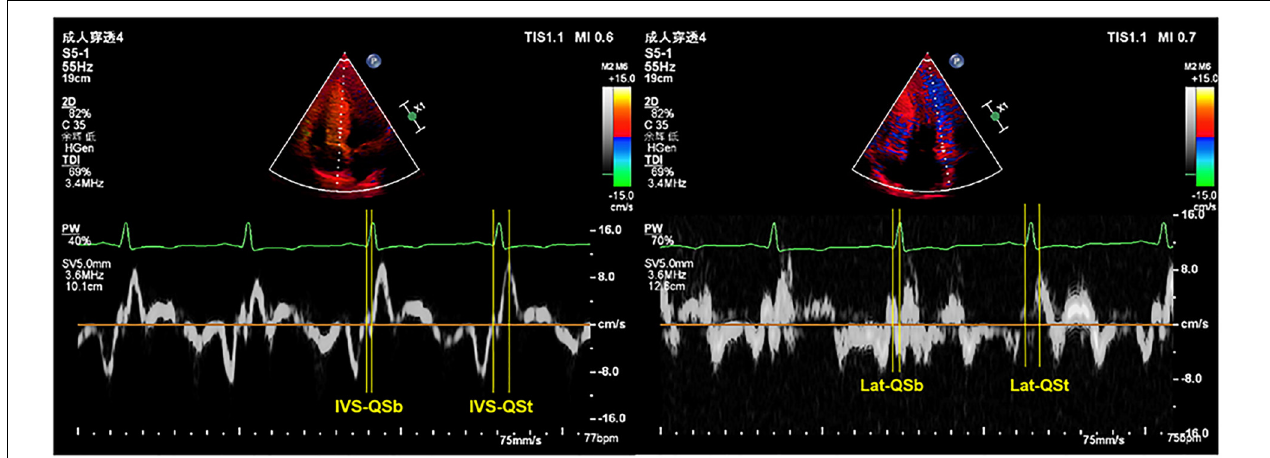
FIGURE 1 | Representative images of TDI combined with ECG to measure the electromechanical coupling time. TDI, tissue Doppler imaging; ECG, electrocardiography; IVS, interventricular septum; Lat, lateral wall; QSb, from the onset of QRS wave on ECG to the beginning of S wave on TDI; QSt, from the onset of QRS wave on ECG to the top of S wave on TDI.